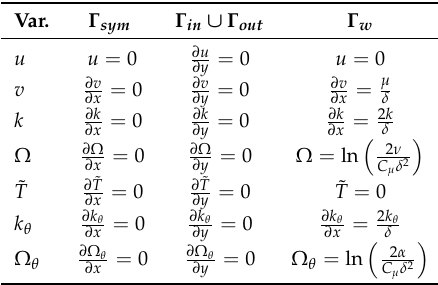
Table 5. Two-dimensional channel tests. Boundary conditions.